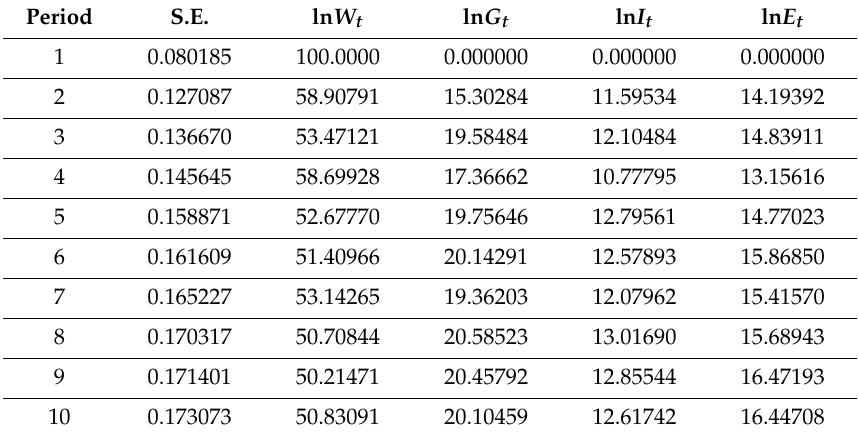
Table 5. Variance decomposition